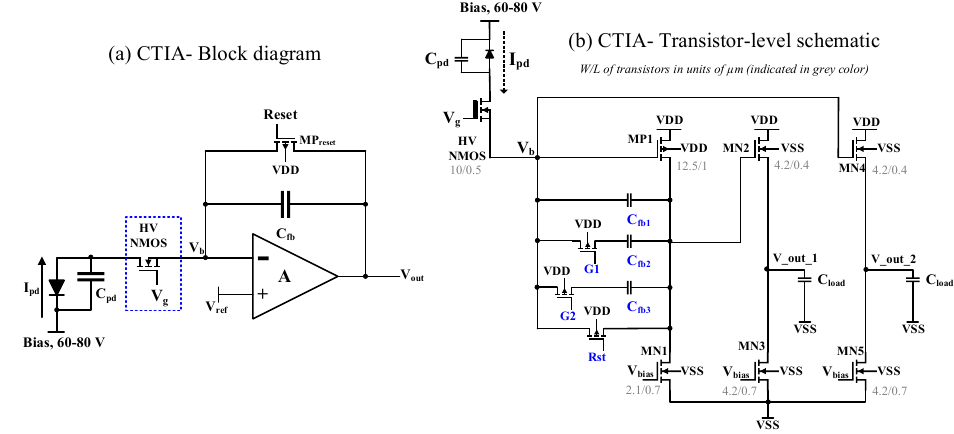
Figure 4. ( a ) CTIA block diagram with HV NMOS transistor; and ( b ) CTIA transistor-level